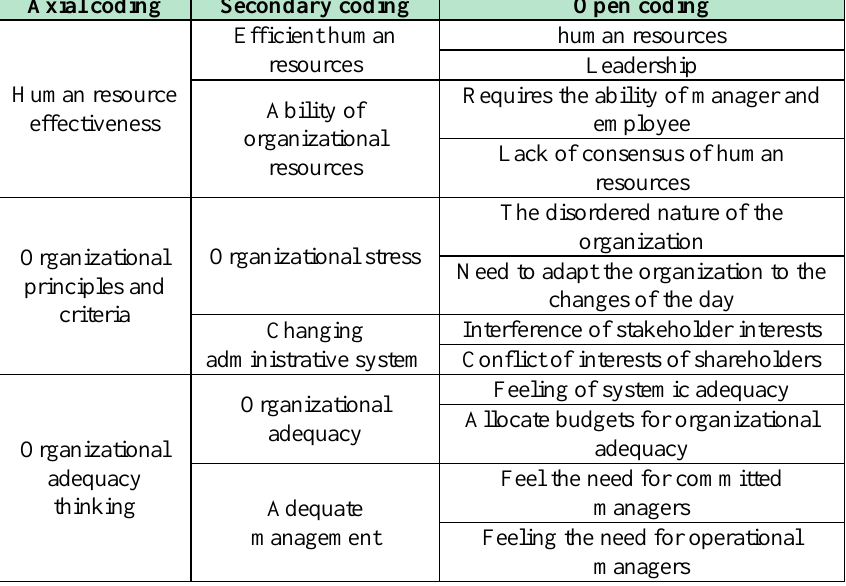
Table 3: Axial coding of qualitative data (intervening conditions) Axial